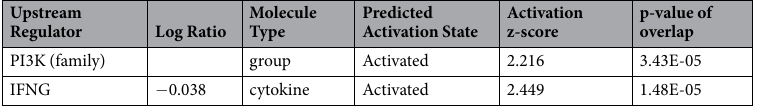
Table 2. Activated/Inhibited Upstream Regulators (Ingenuity) M vs .PT.